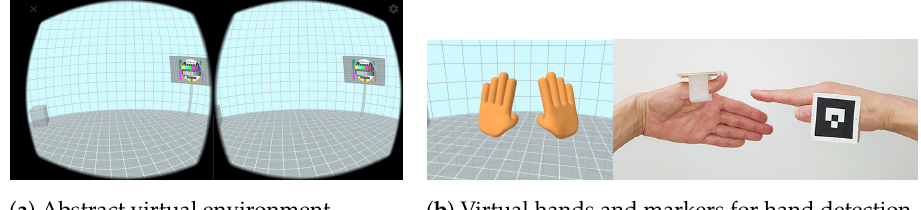
Figure 4. Abstract environment and hand detection in the Tangible VR Book